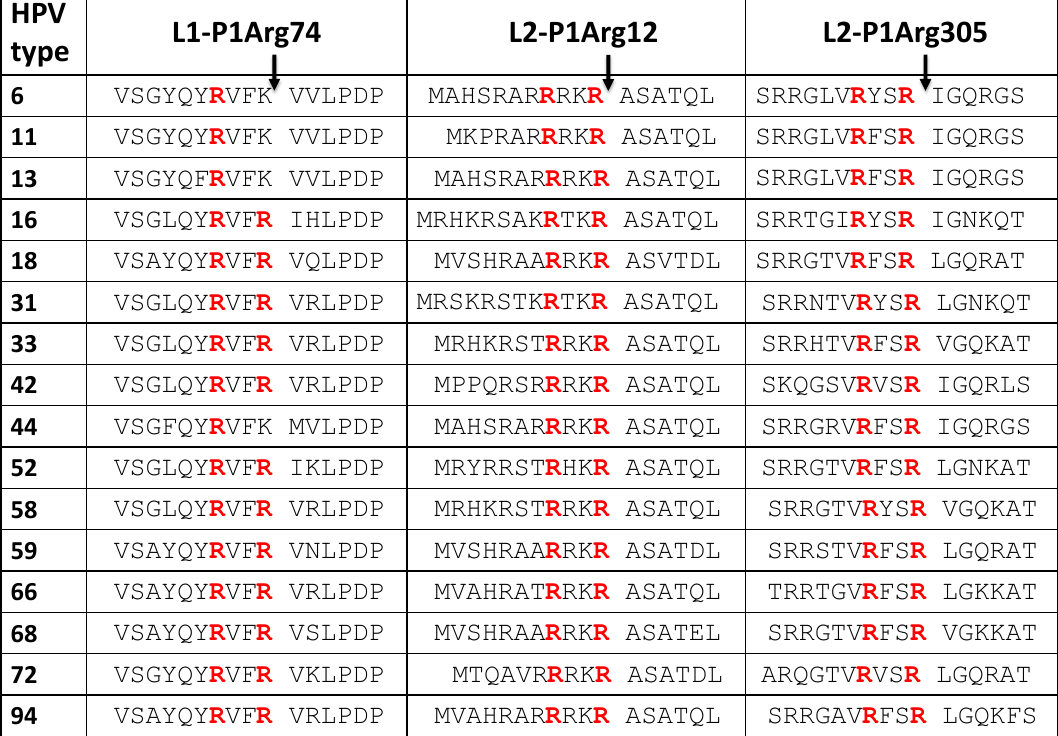
Table 2. PC cleavage site motifs in the coat proteins L1 and L2 of HPV types. The cleavage site numbers correspond to those in the HPV16 sequences. The P4Arg and P1Arg residues are denoted in red.